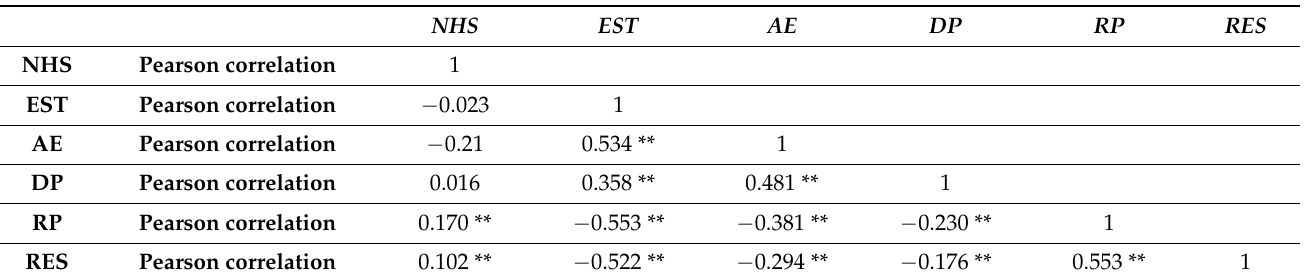
Table 3. Correlational study of variables.